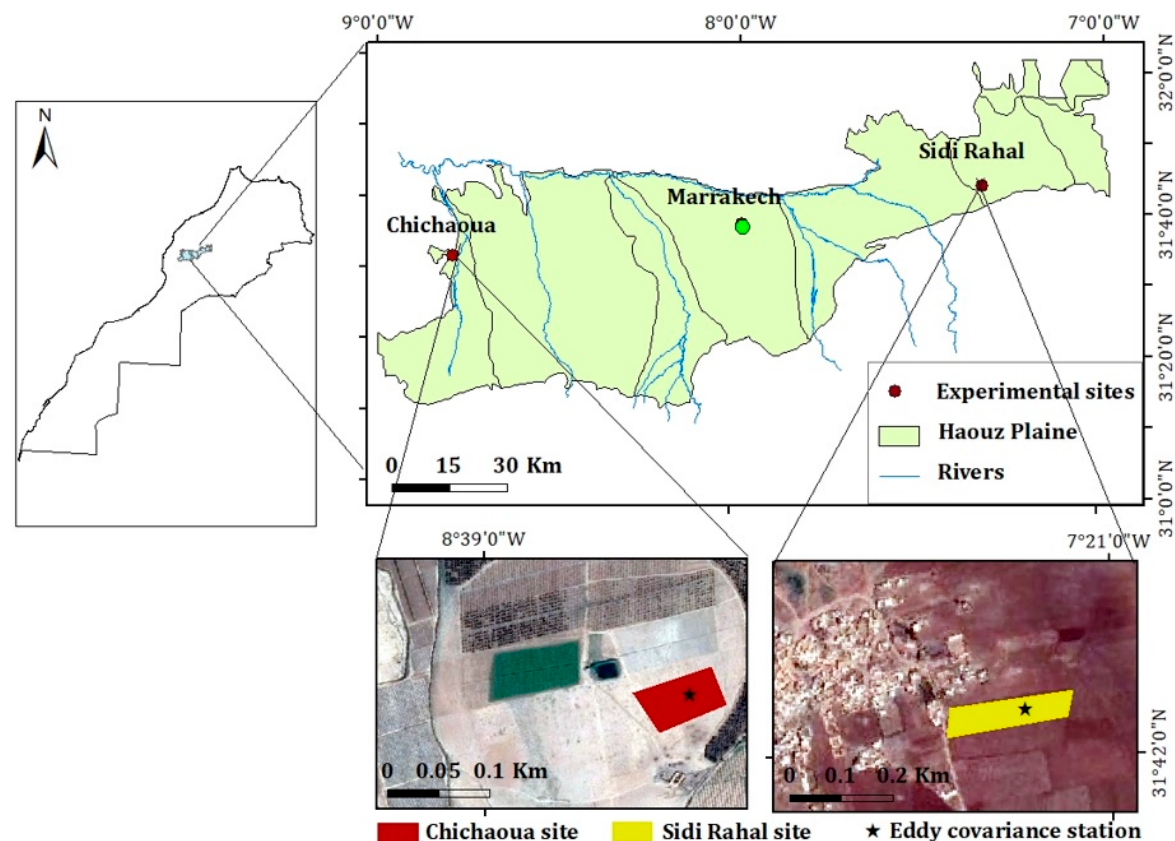
Figure 1. Location of the two study sites, the rainfed wheat crop in the Sidi Rahal area (East of Marrakech) and the drip-irrigated wheat crop in the Chichaoua site (West of Marrakech) in the Haouz Plain.